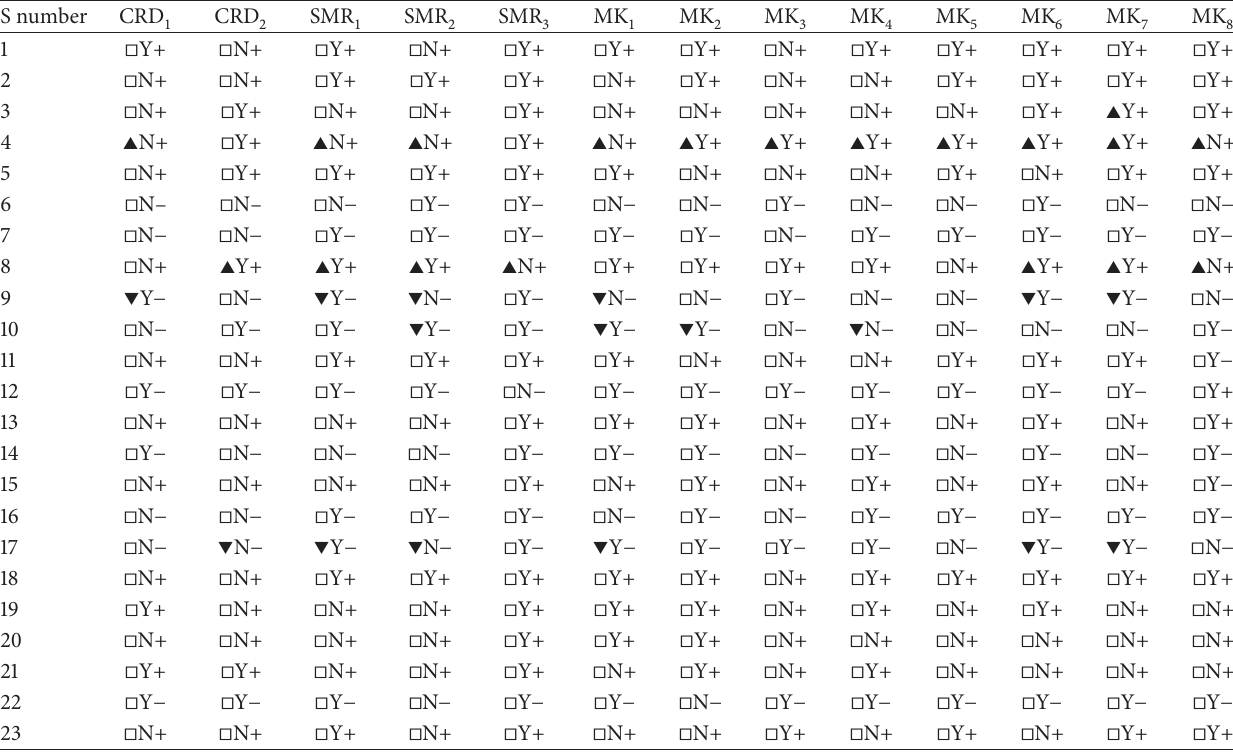
Table 2: Summary of monotonic trend